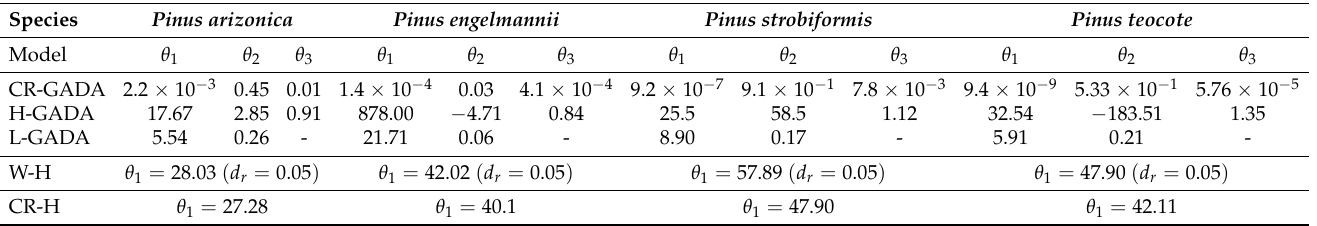
Table 3. Parameters adjusted for the GADA and W-H models in comparison with the CR-H model proposed in the